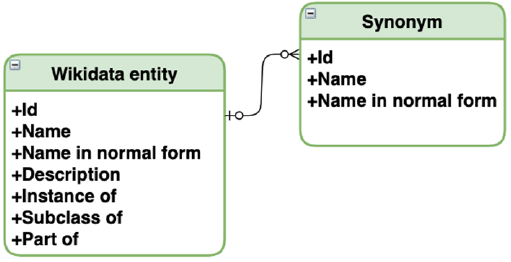
Figure 7. Medical database schema.